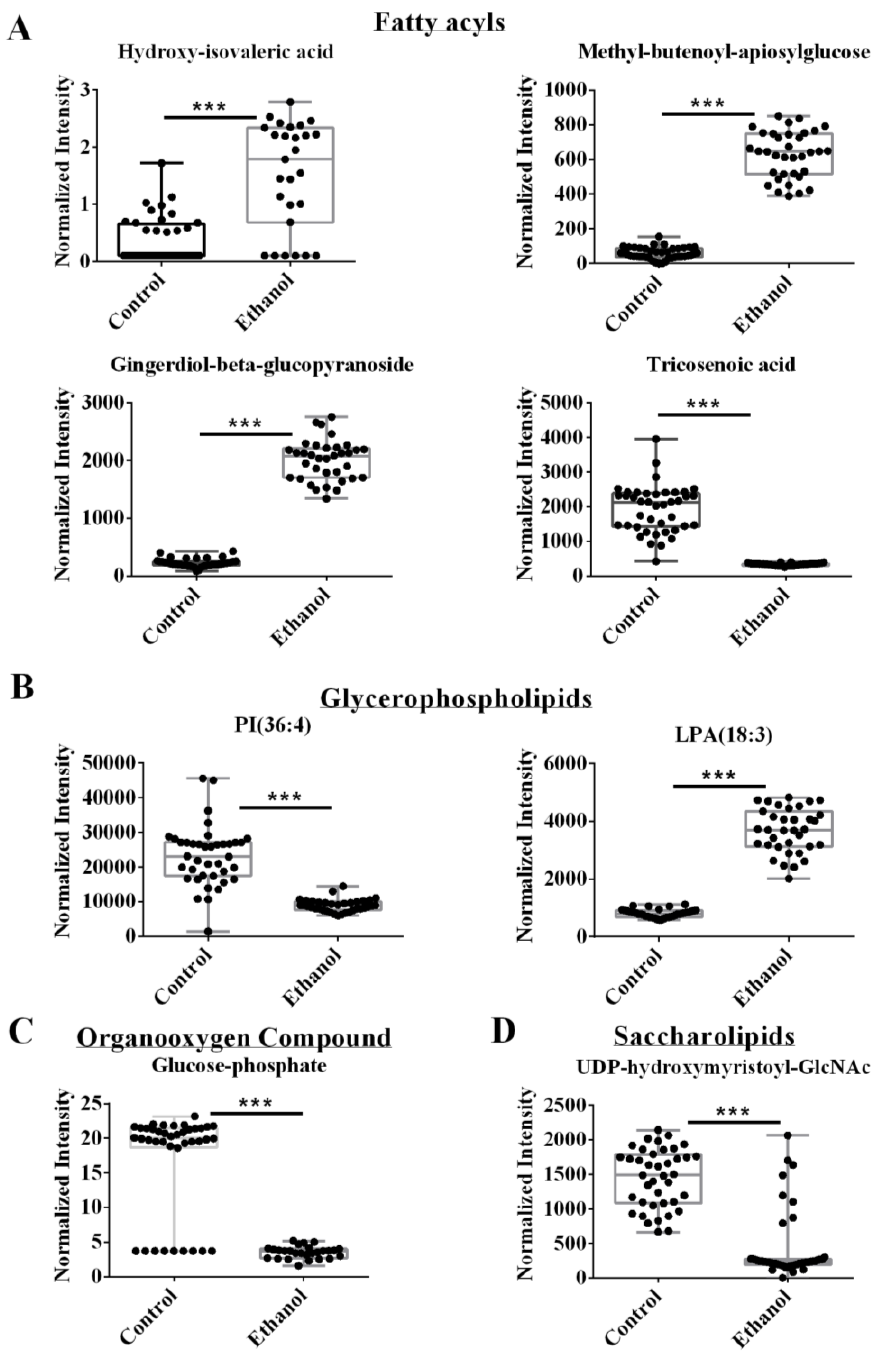
Figure 3. Representative box plots of VIP metabolites or lipids identified from the integrated metabolomics and lipidomics data set with a VIP > 1.19 and an FDR p -value < 0.05 using the Benjamini- Hochberg method. Compound class and names are listed above the box plots. *** p- value < 0.001.